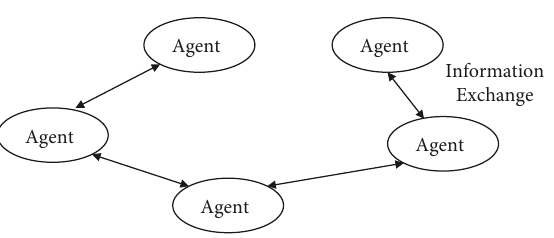
Figure 7: Distributed MAS structure.